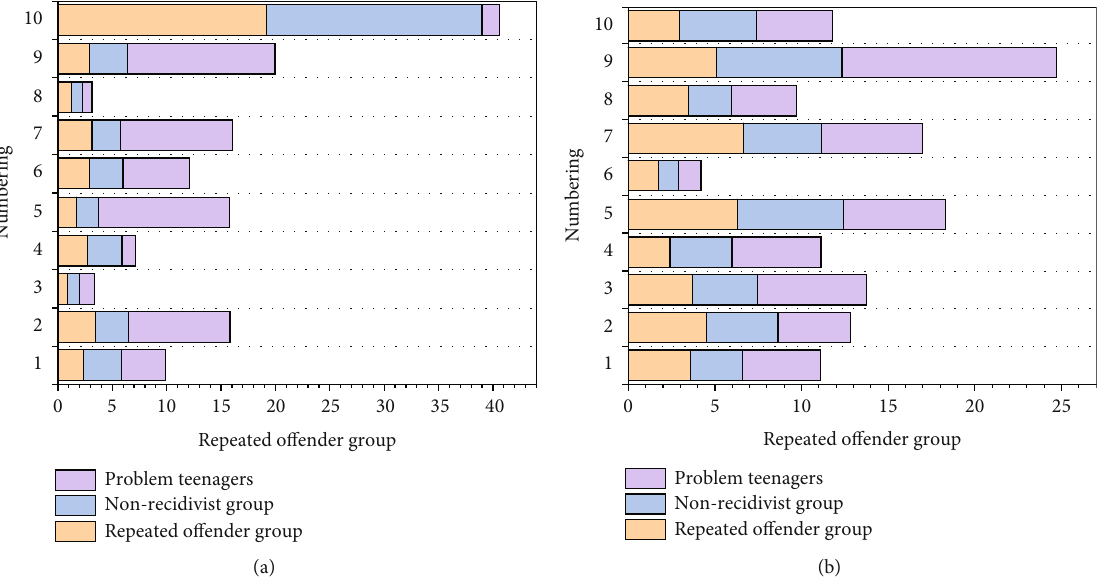
Figure 5: OR values of di ff erent groups of adolescents in DQ and ANG scales compared with normal youths ((a) OR value in the DQ scale) and (b) OR value in the ANG